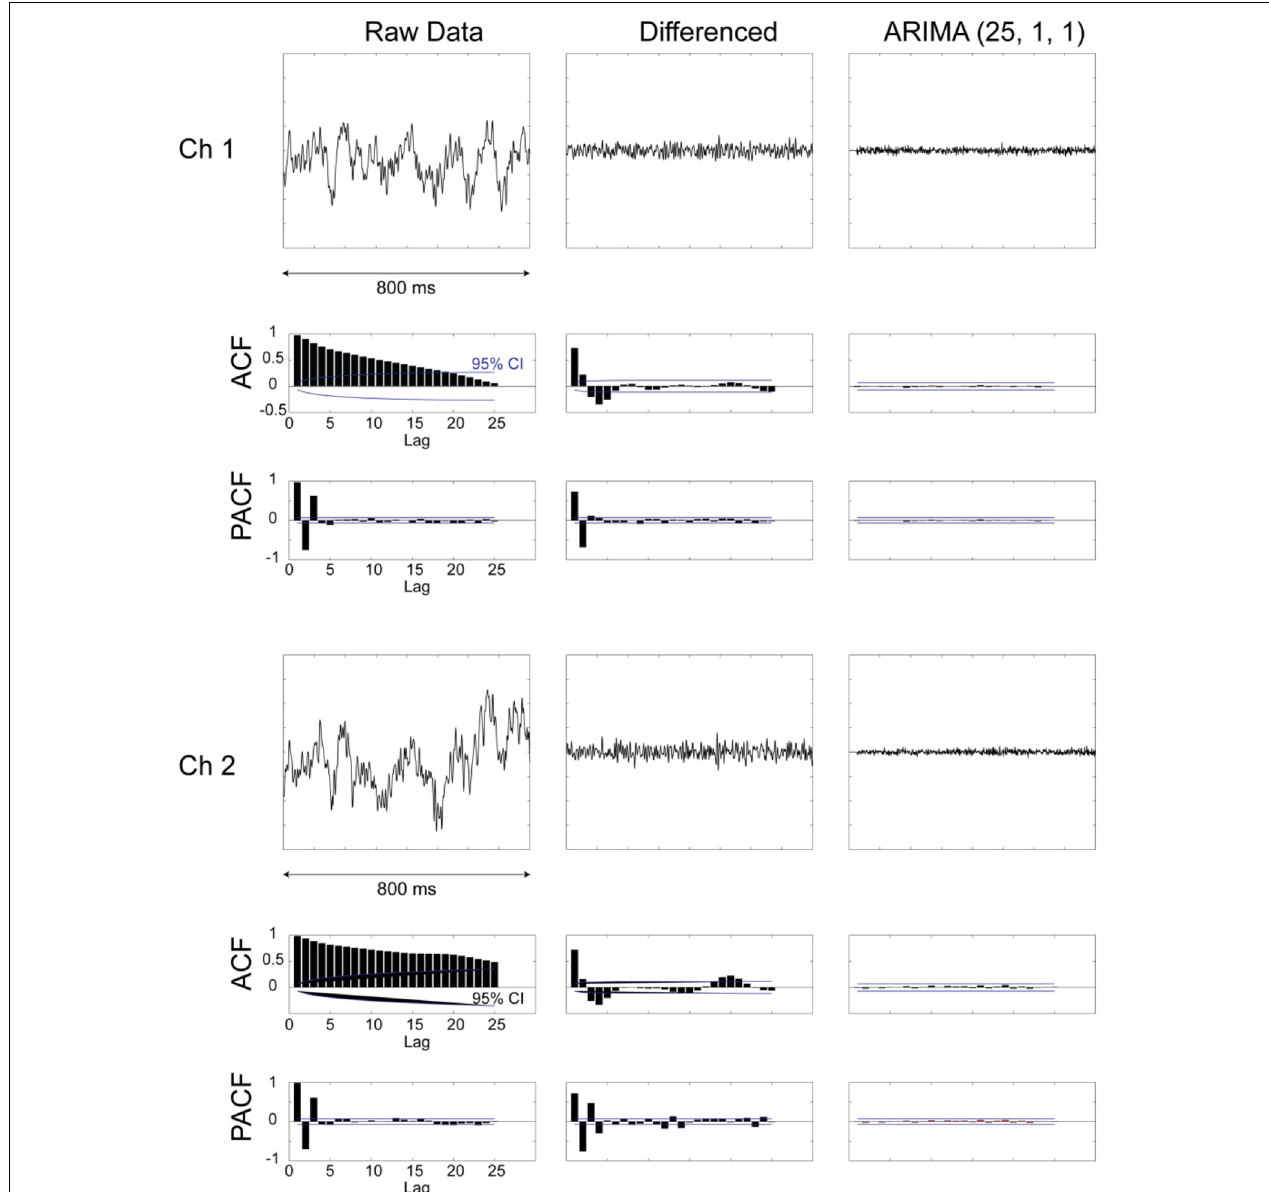
FIGURE 3 | Examples from two LPF recordings and their preprocessing for prewhitening. Plots are shown for raw data, data after first-order differencing, and after applying an ARIMA [25,1,1] model. In addition, plots of autocorrelation function (ACF) and partial